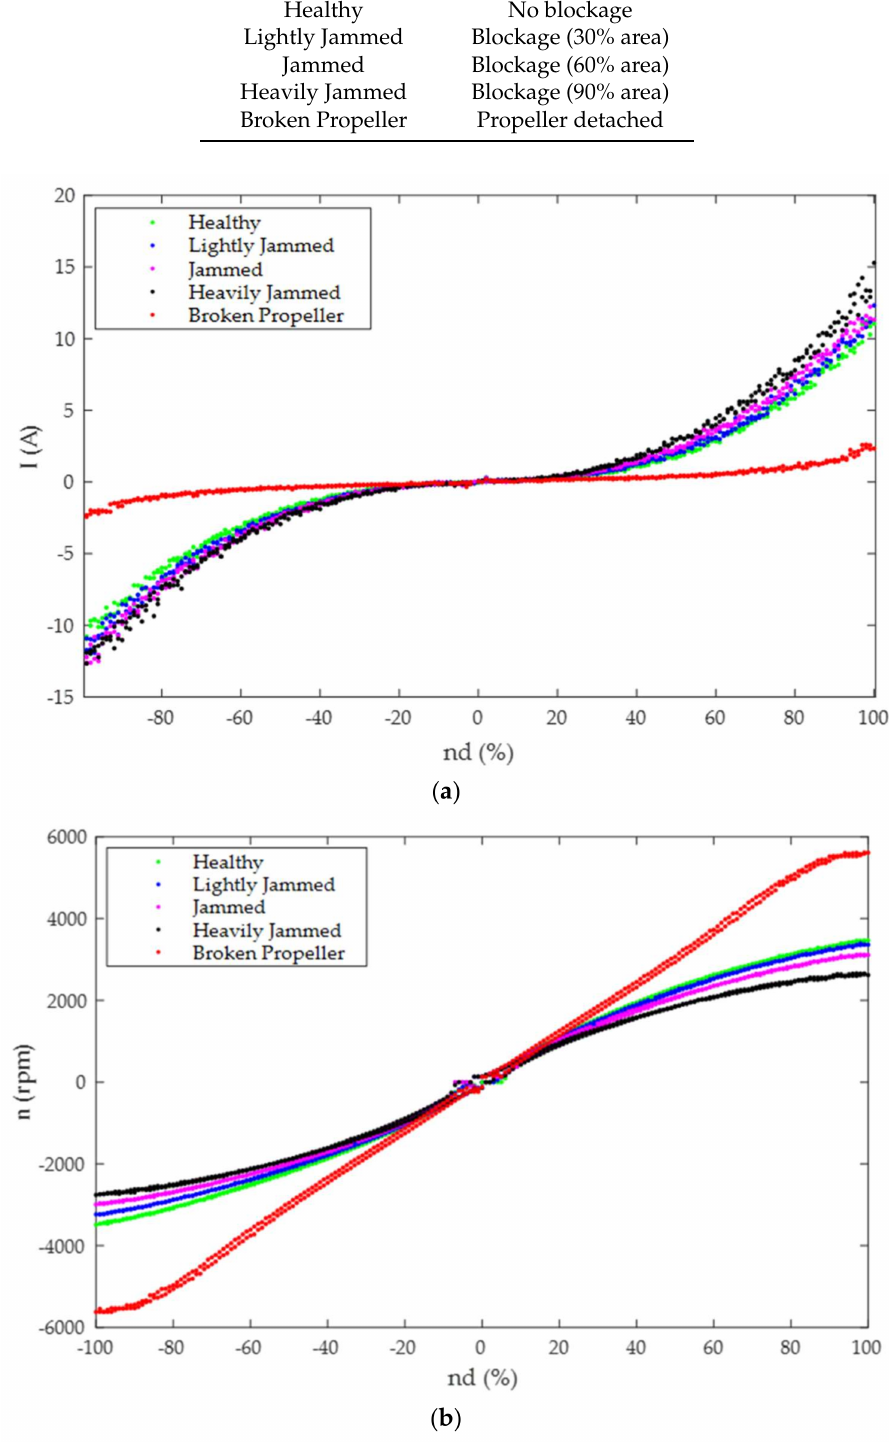
Figure 5. Diagrams of raw training data: ( a ): I versus n d plot; ( b ) n versus n d